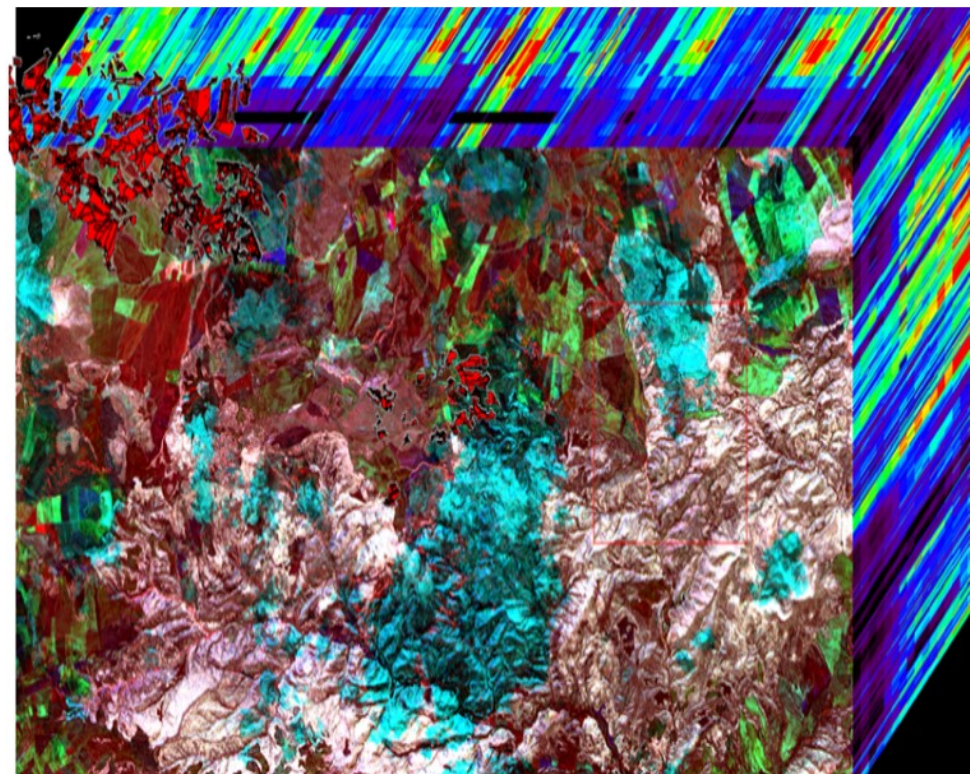
Figure 7. Example of the ITSSC file (in red the pilot